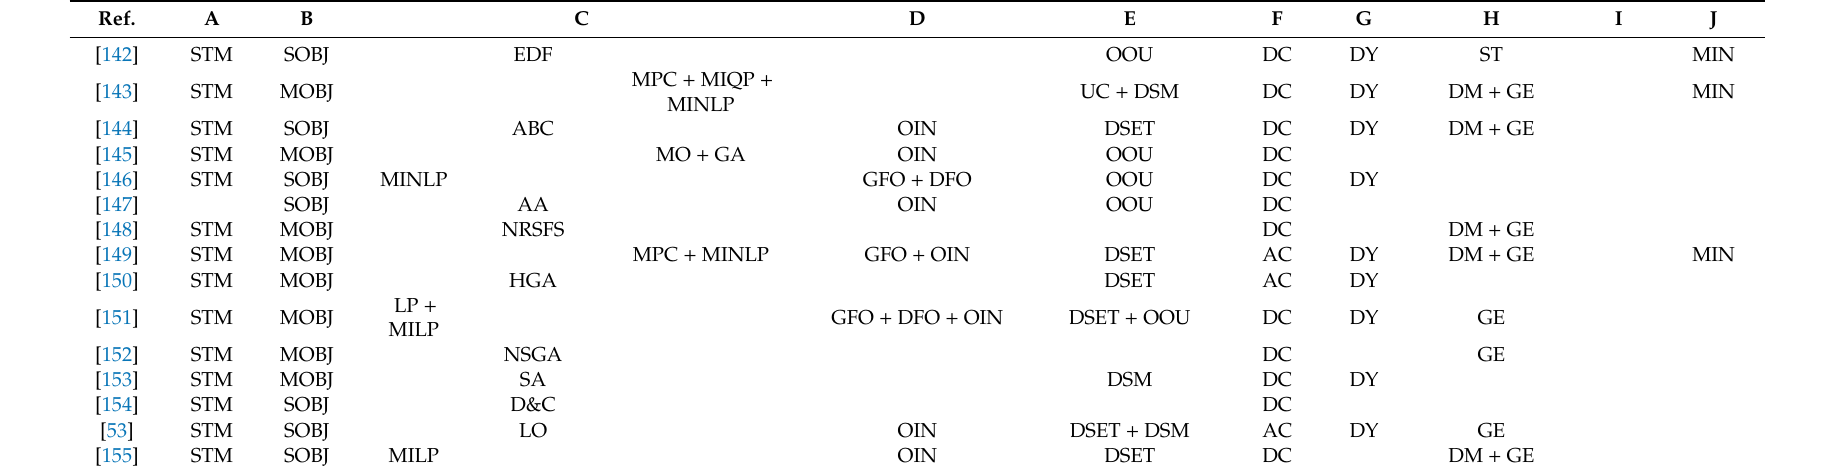
Table A9. Papers published in